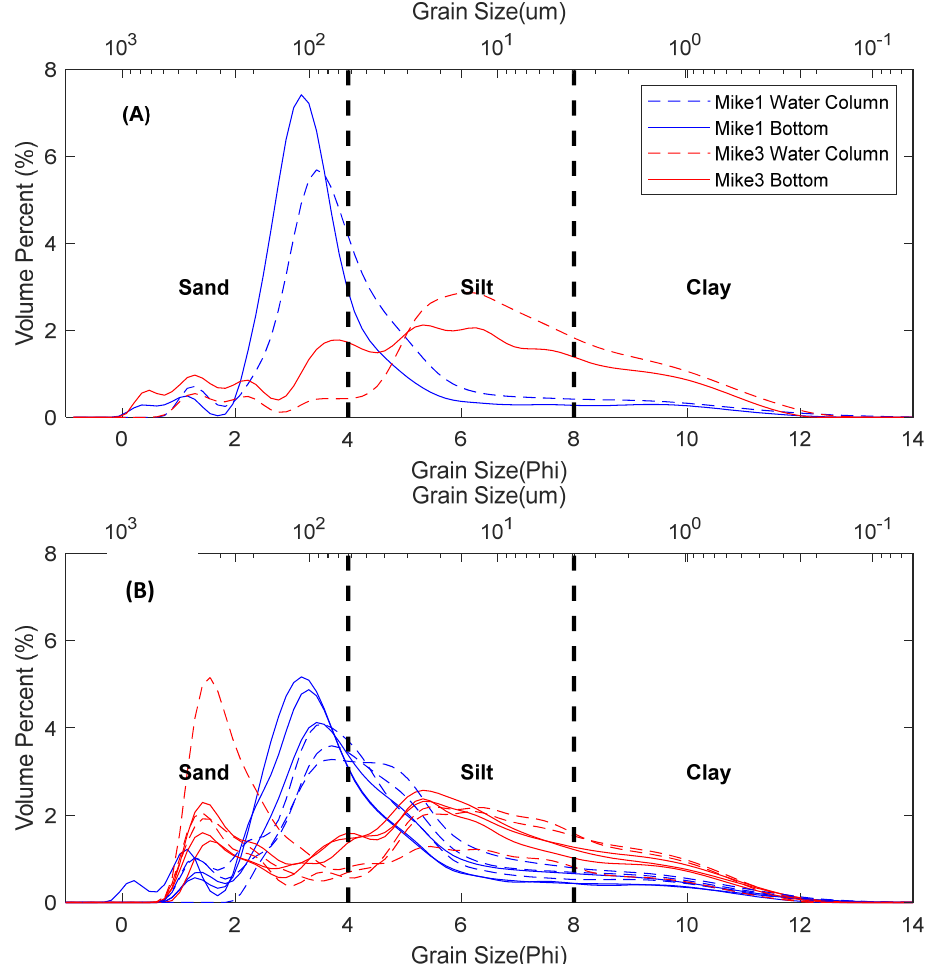
Figure 12. Grain size distribution ( µ m) of sediment collected in the traps during ( A ) 28 March–2 May 2015 and ( B ) 28 August–2 October 2015. See Figure 2C showing the trap setup at bottom (sediment surface) and water column (30 cm above sediment surface) positions.